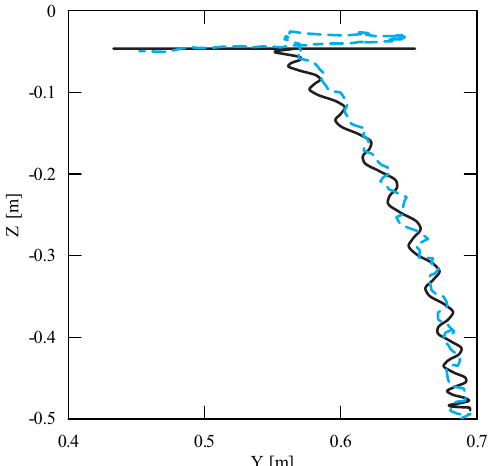
Figure 17. Projection of the trajectory of the transferred load in the lifting plane YZ (solid line— numerical calculations; dashed line—experiment